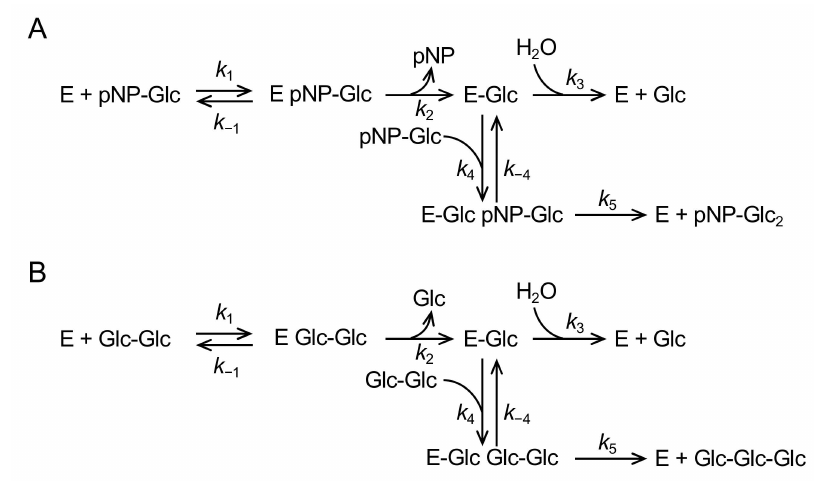
Figure 6. Reaction scheme for the reaction with pNPG ( A ) and G2 ( B